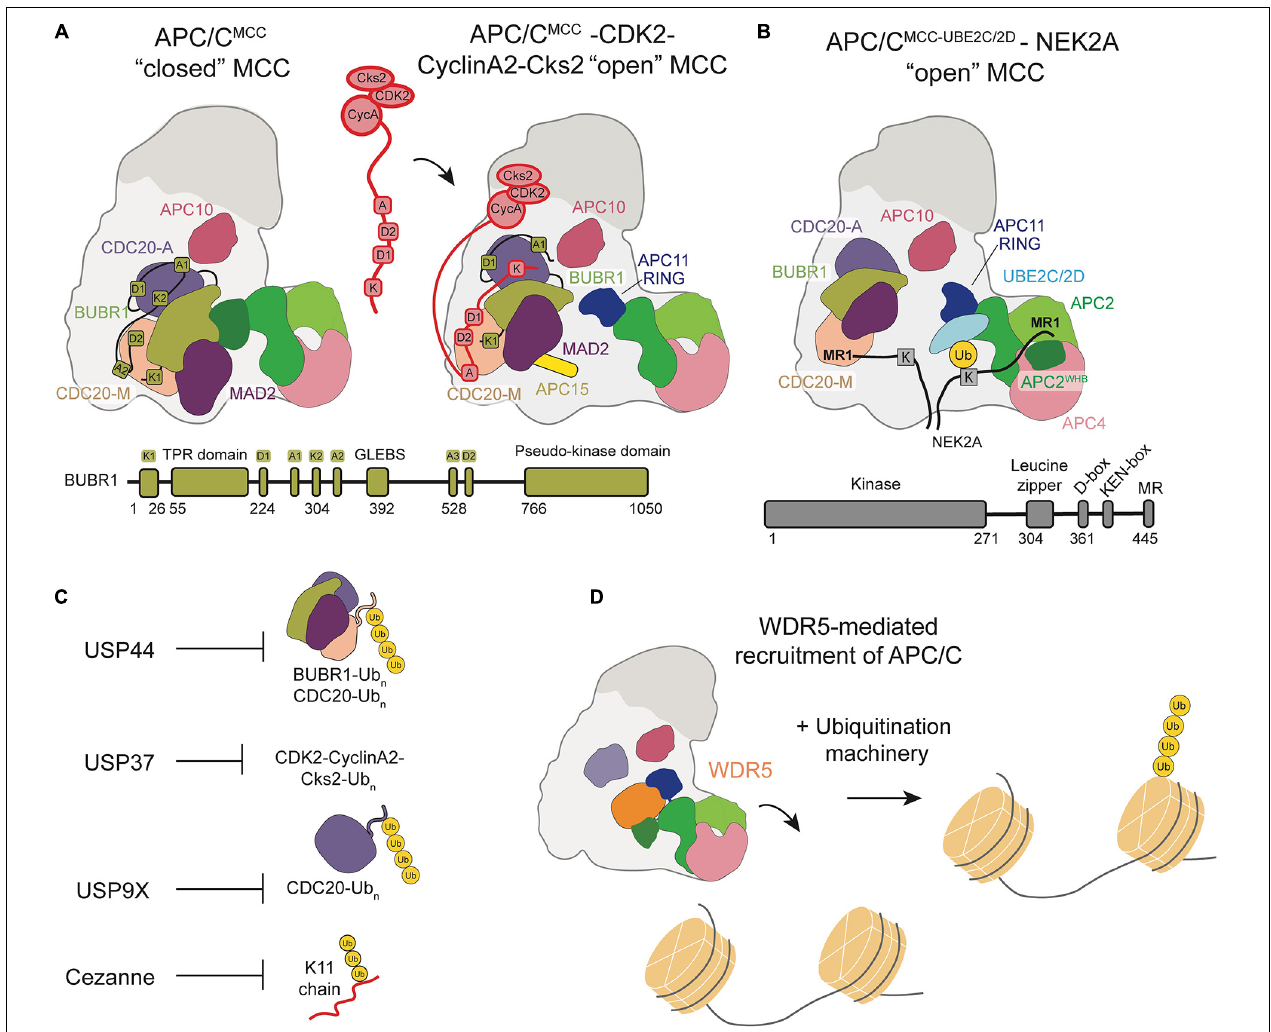
FIGURE 4 | Schematic of APC/C regulation and chromatin regulation by the APC/C. (A) Model of the CDK2-Cyclin-A2-Cks2 complex bound to APC/C MCC in the “open” conformation show how multiple Cyclin-A binding recognition motifs displace BubR1 binding motifs, allowing for Cyclin A to bypass MCC inhibition. (B) Depiction of NEK2A binding to APC/C MCC “open” with NEK2A binding as a dimer and the MR1 motifs of each monomer binding either at APC8 or near the APC2/4 groove that binds the UBE2S CTP . (C) Summary of the DUBs that counteract APC/C ubiquitination throughout the cell cycle. (D) WDR5 recruits the APC/C to the nucleosome facilitating APC/C-mediated ubiquitination of